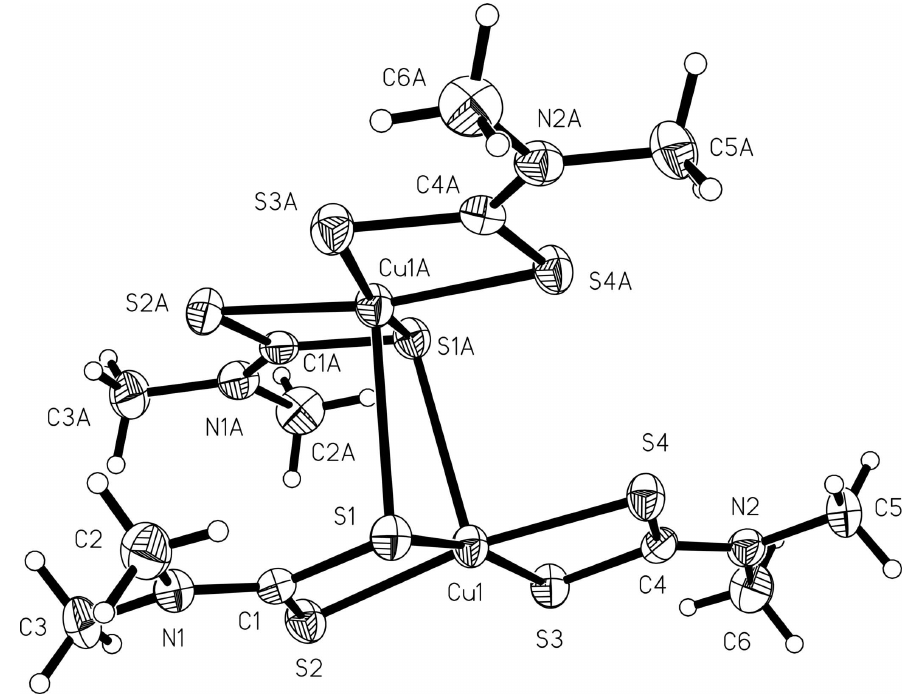
Figure 1 The molecular structure of (I) with 30% probability displacement ellipsoids (arbitrary spheres for H atoms). [Symmetry code: A 1 - x , y , 1/2 - z.